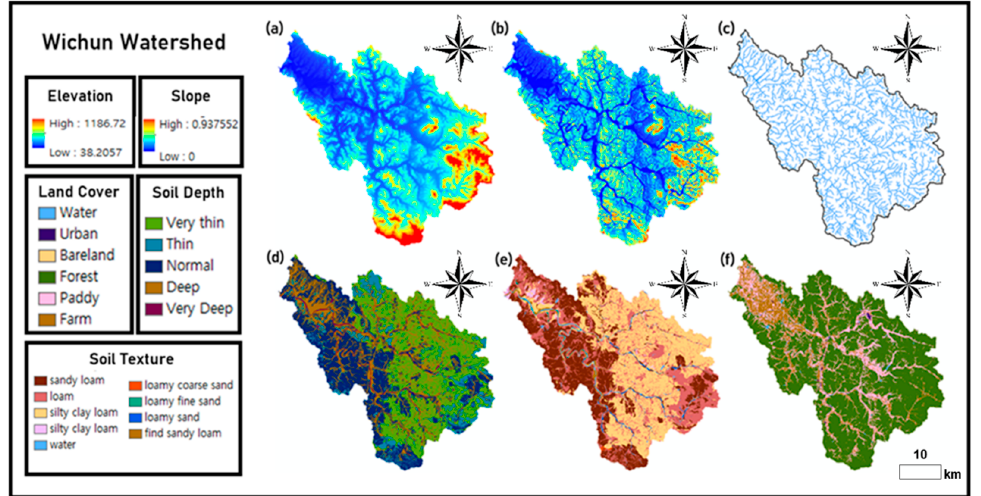
Figure 1. Main features of Wicheon watershed. ( a ) DEM; ( b ) Slope; ( c ) Stream; ( d ) Land cover; ( e ) Soil depth; ( f ) Soil texture.